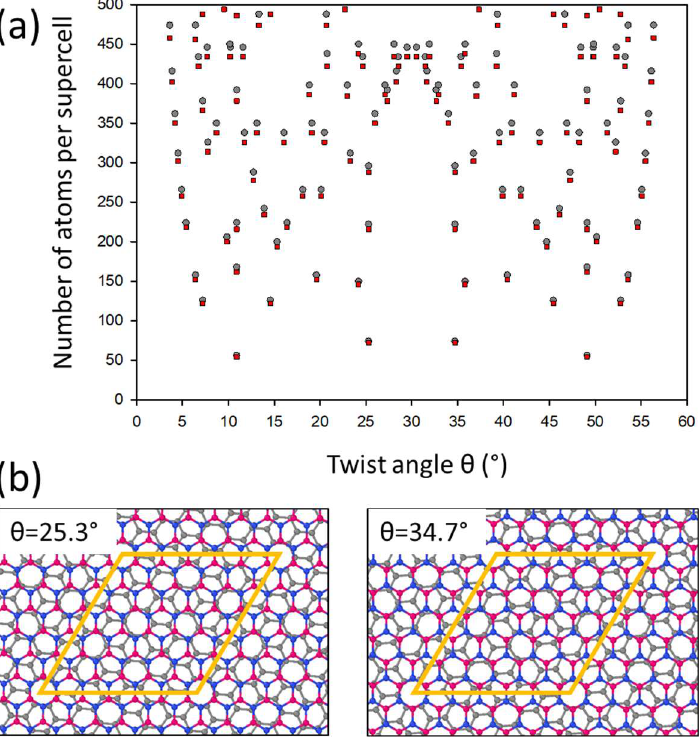
Table 1. Parameters of the considered G/BN supercells.